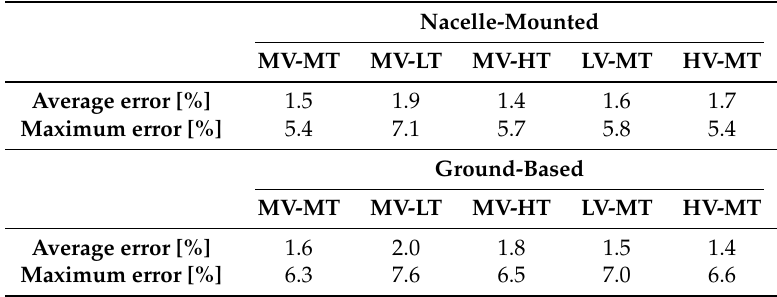
Table A2. The minimization of the average and maximum errors found inside the volume of interest indicates that the optimum values for the angular resolution are always between 2.5 and 4 ◦ , so 3 ◦ is chosen again as an overall optimum angular